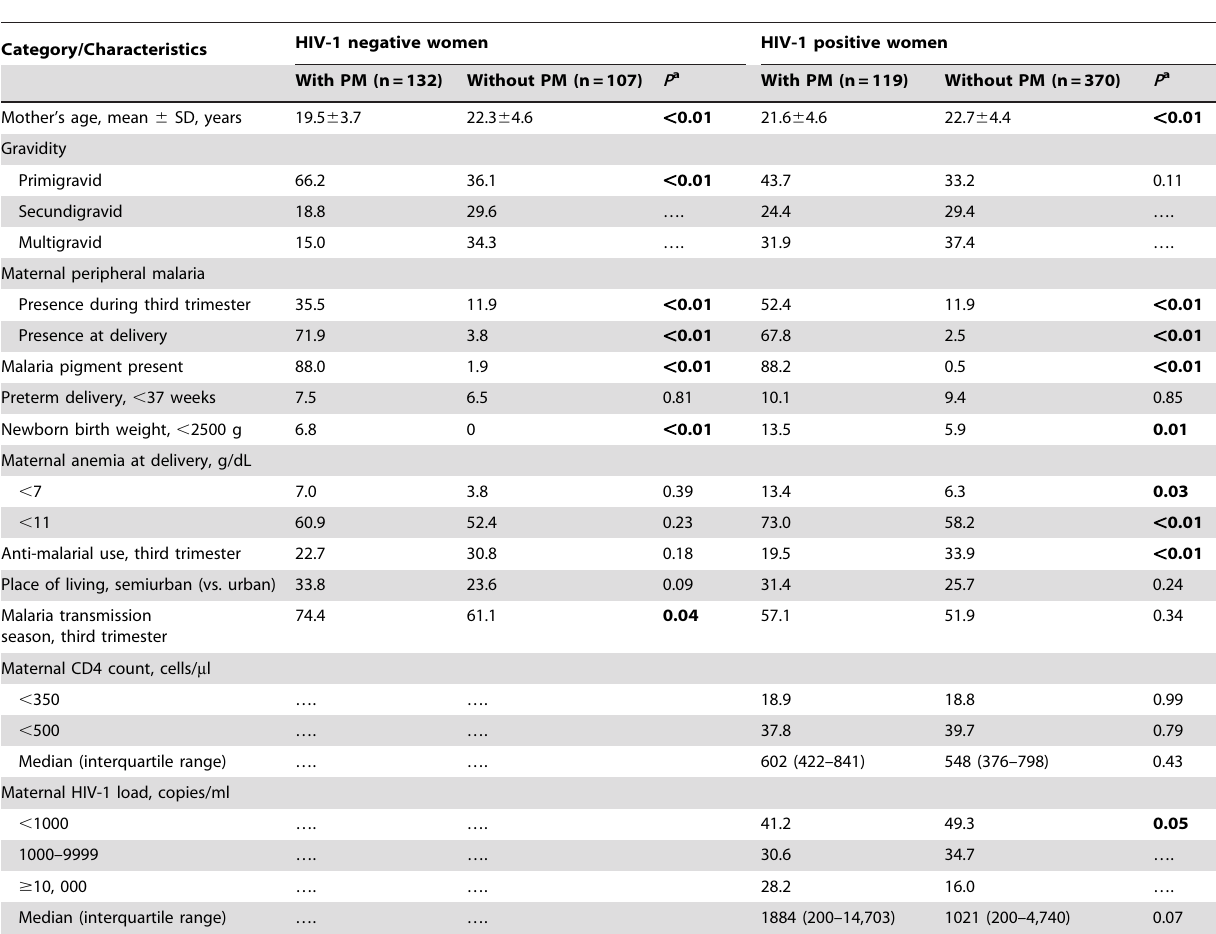
Table 1. Characteristics of HIV-1 negative and HIV-1 positive women, by placental malaria (PM) status.